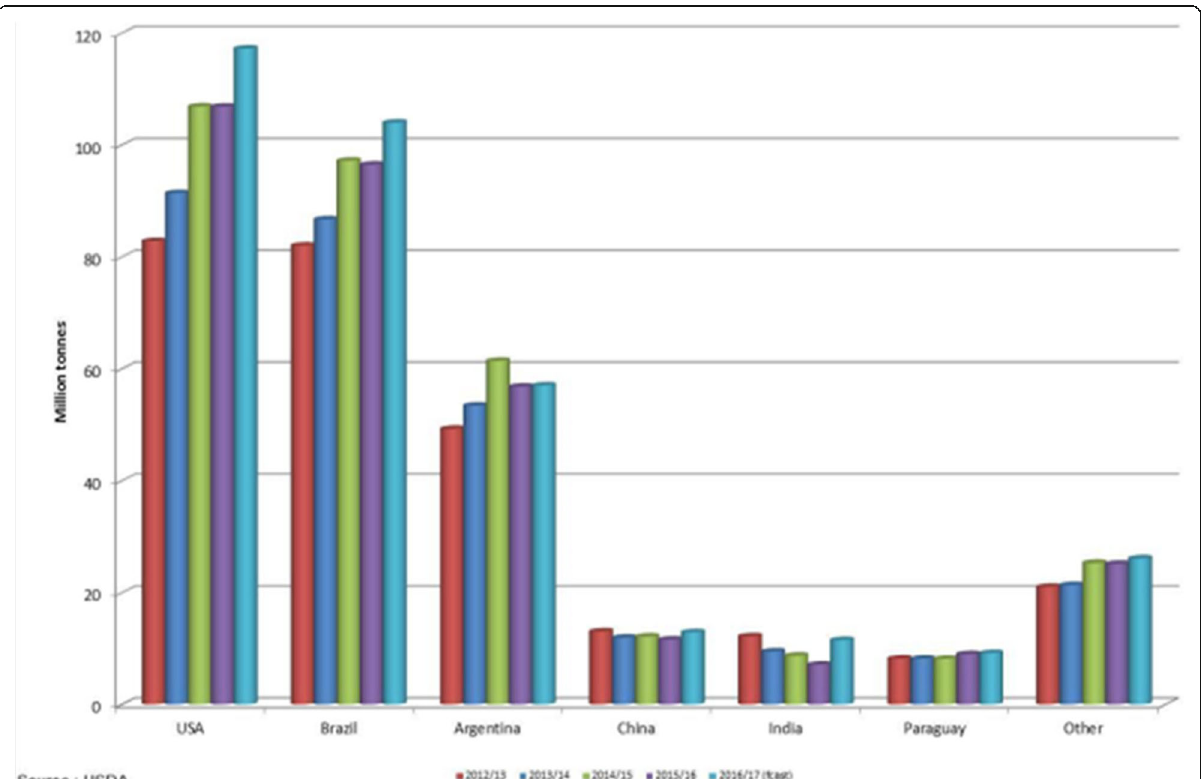
Fig. 3 Production of soybean per country over the years from 2012 to 2016. [Source: USDA (European Commission, 2017)]